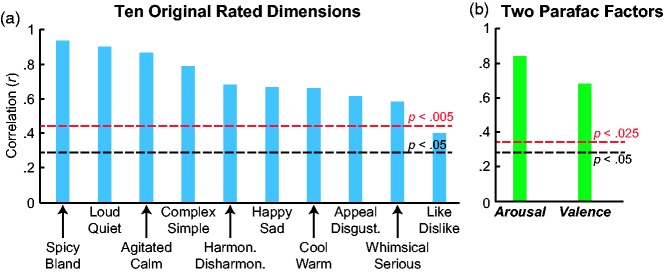
Correlations between the average emotion-related ratings of the 34 musical excerpts and the weighted average emotion-related ratings of the colors chosen as going best/worst with the musical excerpts (EMCAs). (a) Correlations for the 10 originally rated emotion scales. (b) Analogous correlations for the two latent factors in the emotion Parafac solution. The black dotted line corresponds to the uncorrected p value cut-off, whereas the red dotted line corresponds to the Bonferroni-corrected p values for conducting multiple comparisons.